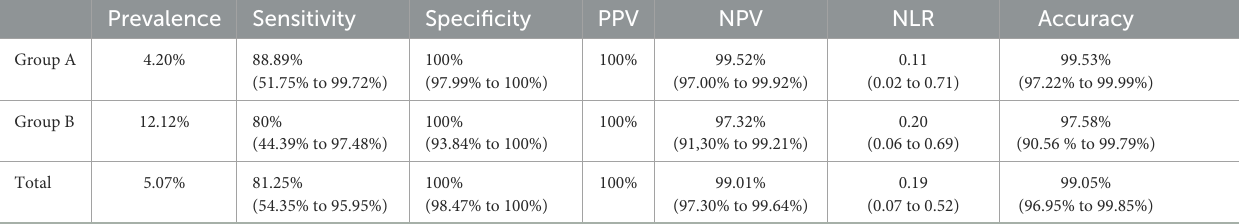
TABLE 3 Performance characteristics of paired test in groups A and B. Prevalence